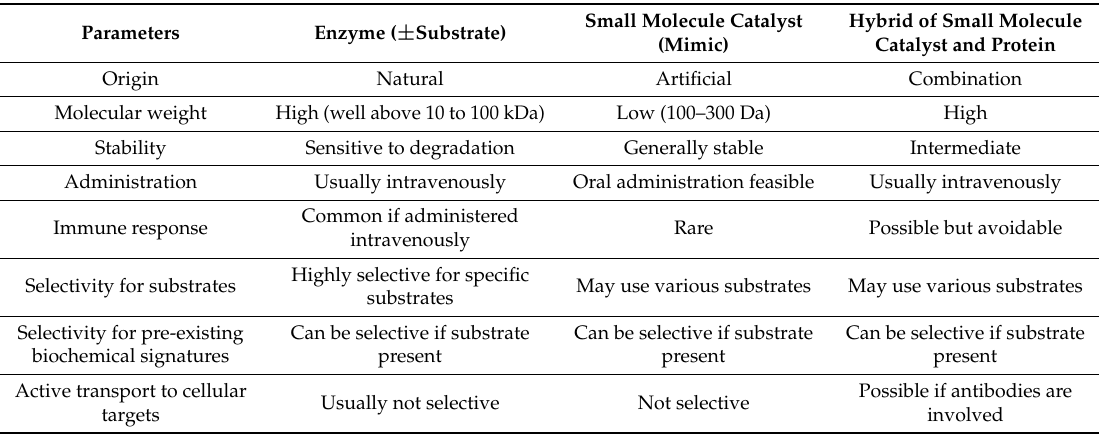
Table 1. Enzymes and enzyme mimics may both be employed in prevention and therapy and both provide individual advantages and disadvantages. Hybrid molecules have recently been considered as a mean to combine such benefits whilst minimizing any drawbacks. See text for